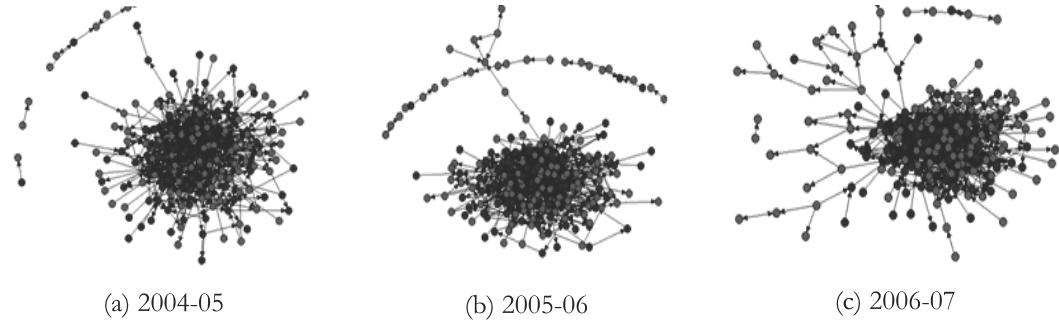
Figure 4 – Whole degree courses networks.